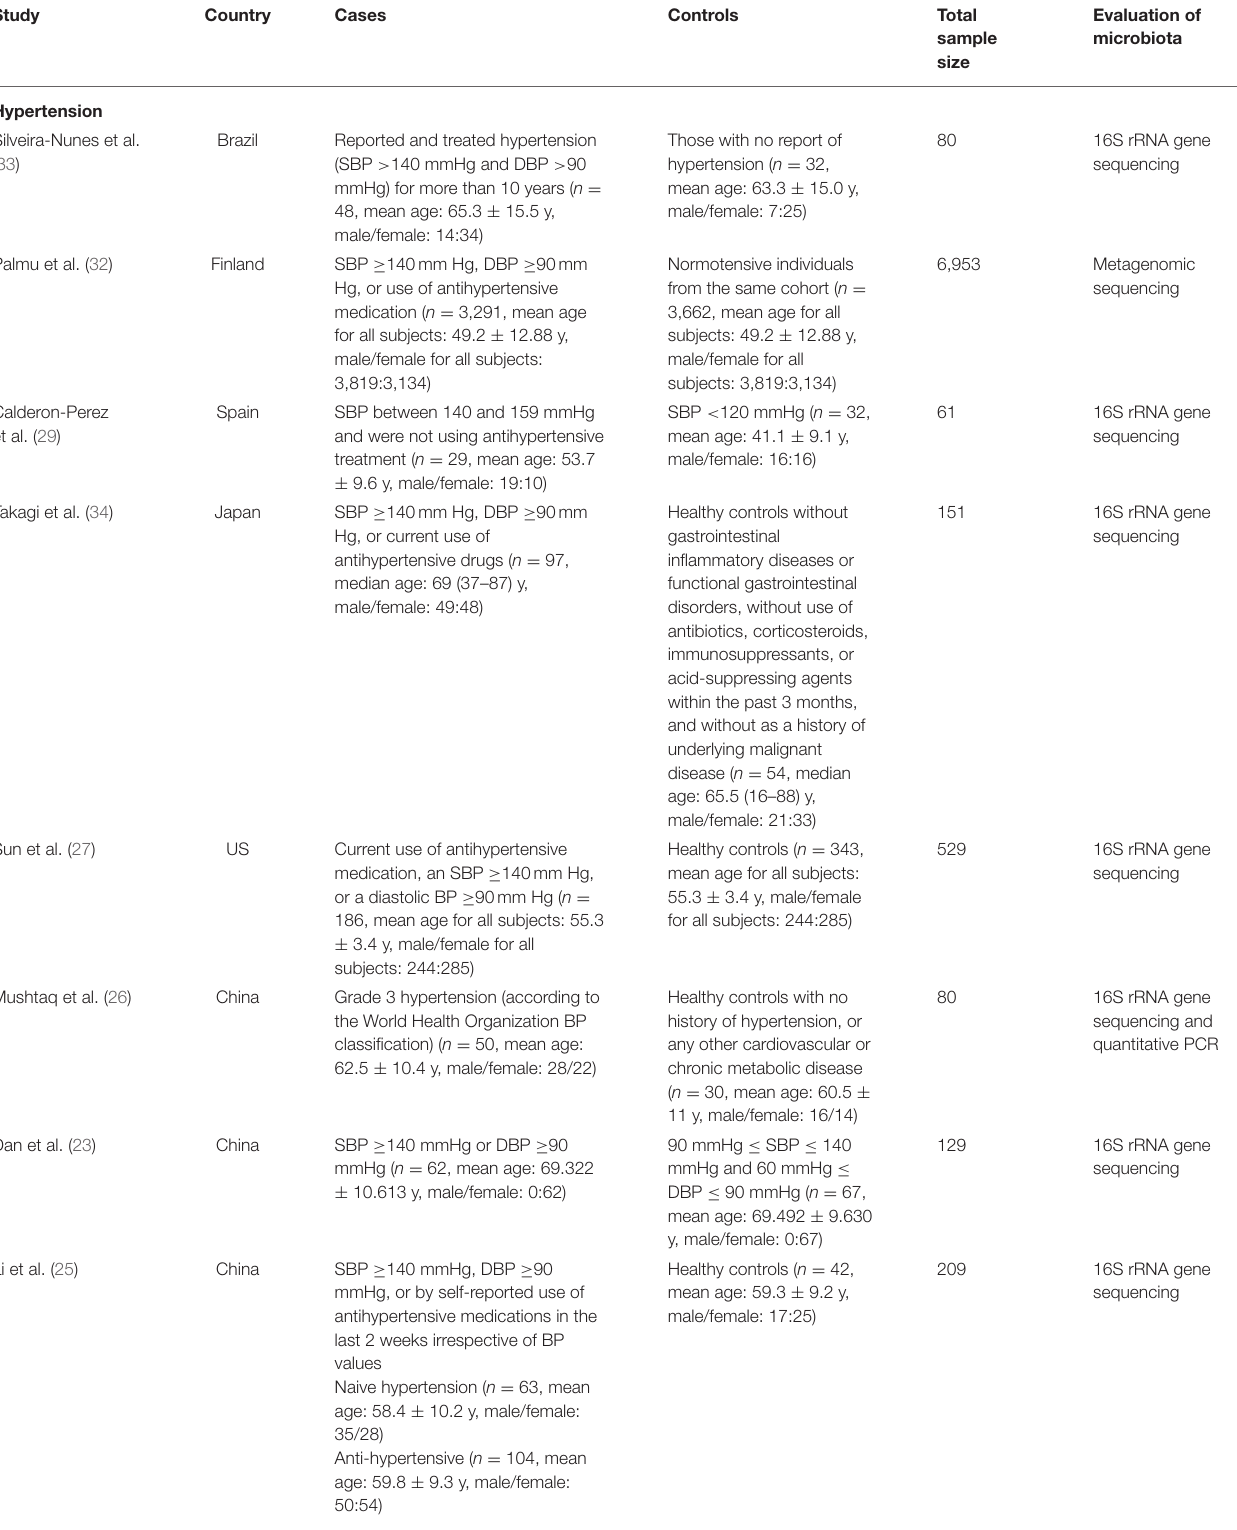
TABLE 1 | Characteristics of the included